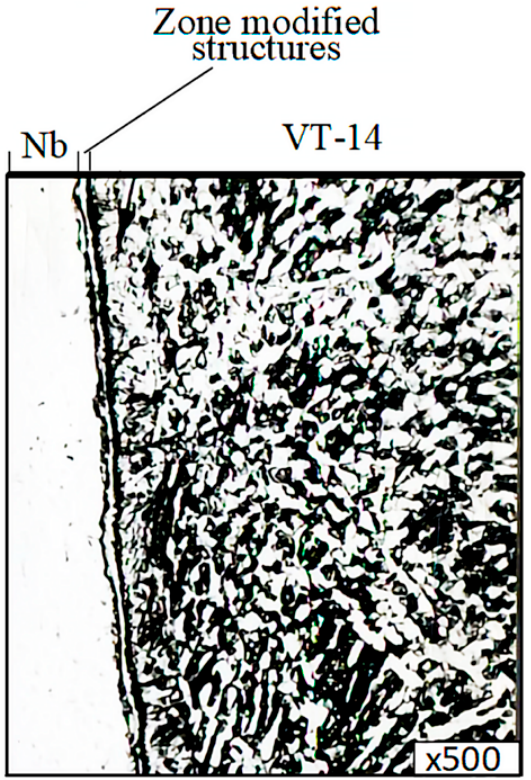
Figure 15. VT-14+Nb connection